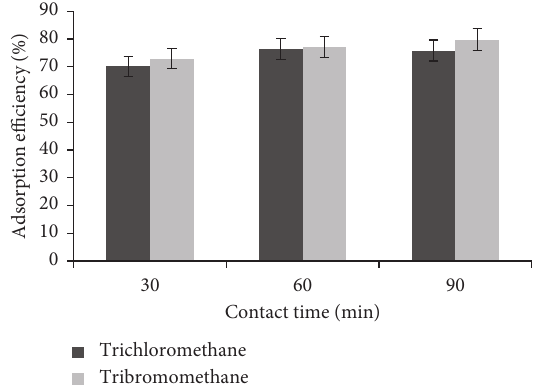
Figure 5: Effect of contact time on adsorption of trichloromethane and tribromomethane in simulated experiment.